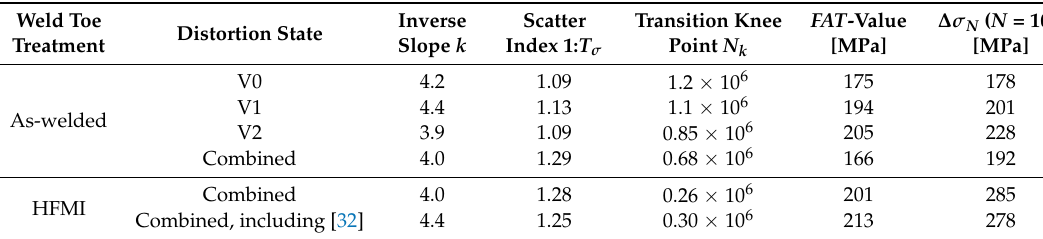
Figure 7. Nominal fatigue test results for as-welded condition. Table 3. Summary of fatigue test results.